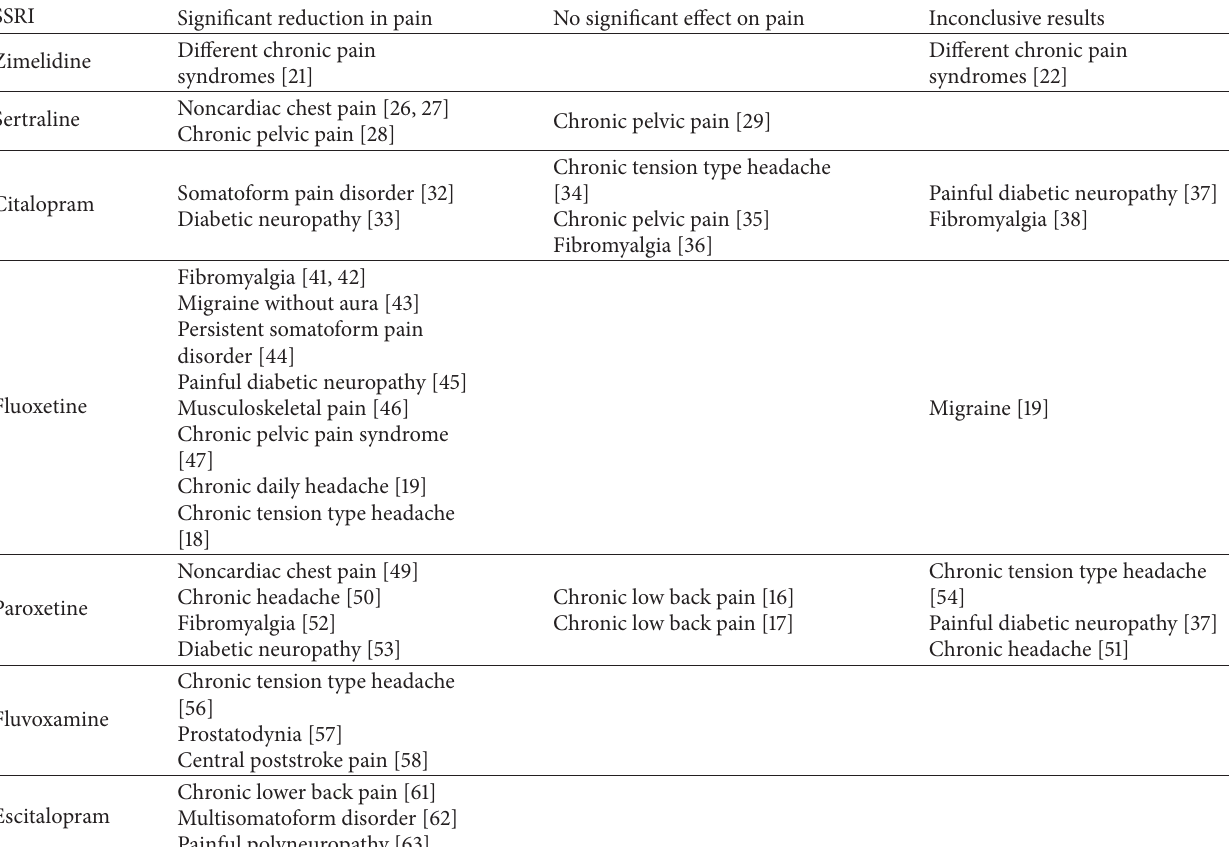
Table 2: Synopsis of the observed effect of the SSRI as treatment for chronic pain